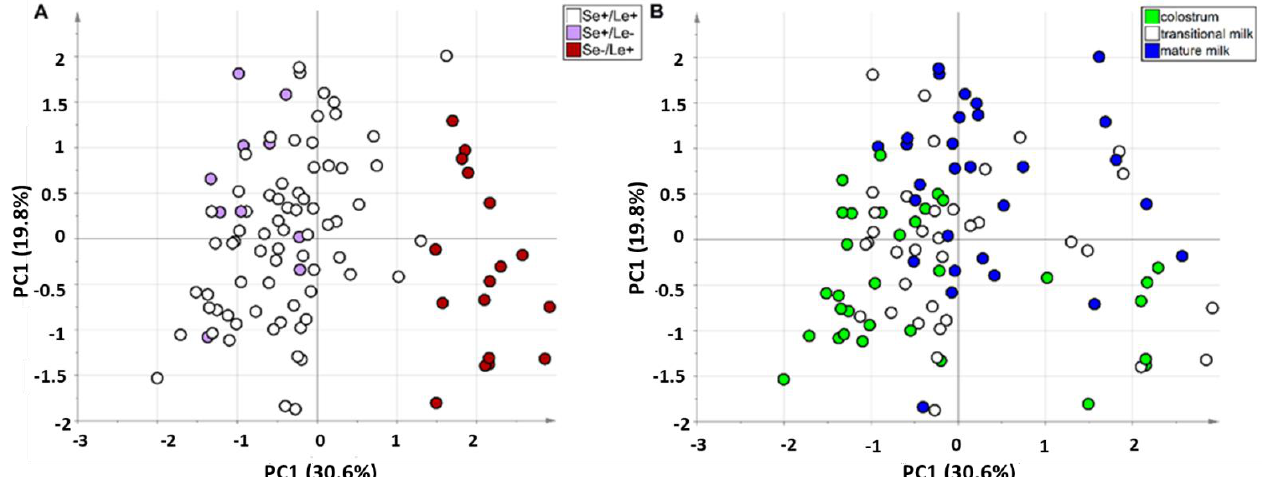
Figure 2. PC1 vs. PC2 score scatter plot of the PCA model built with the binned data, colored according to maternal HMO phenotype (panel ( A ): Se + /Le + in white; Se + /Le − in violet; Se − /Le + in red) and lactation stage (panel ( B ): colostrum in green; transitional milk in white; mature milk in blue).